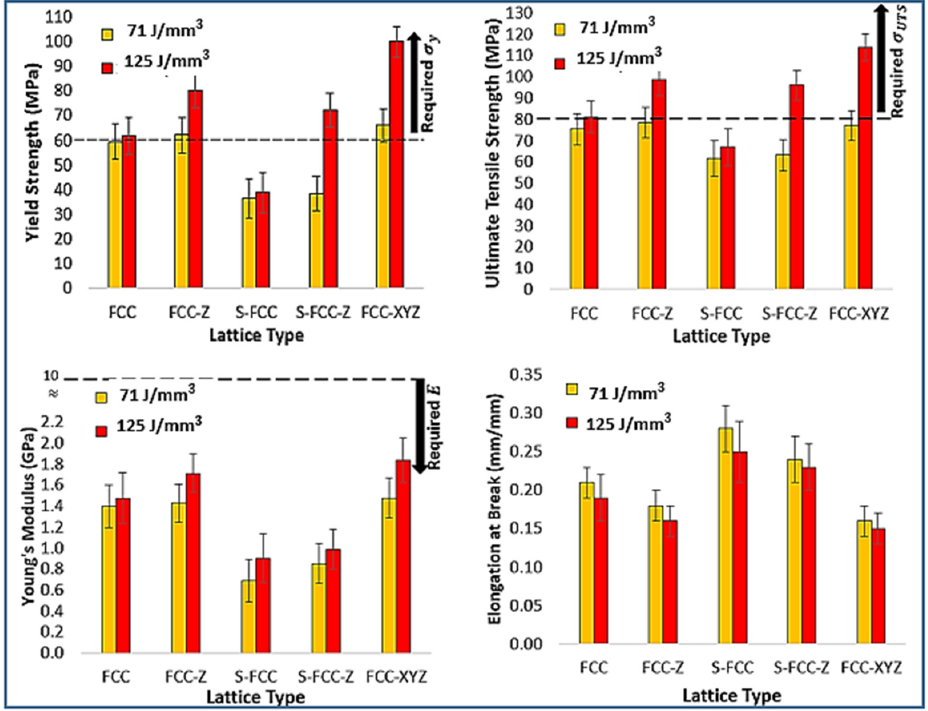
Figure 9. The tensile properties of SLMed objects with five types of lattice structures, yield strength at 0.02 offset from plateau start, ultimate tensile strength, Young’s modulus, and elonga- tion at